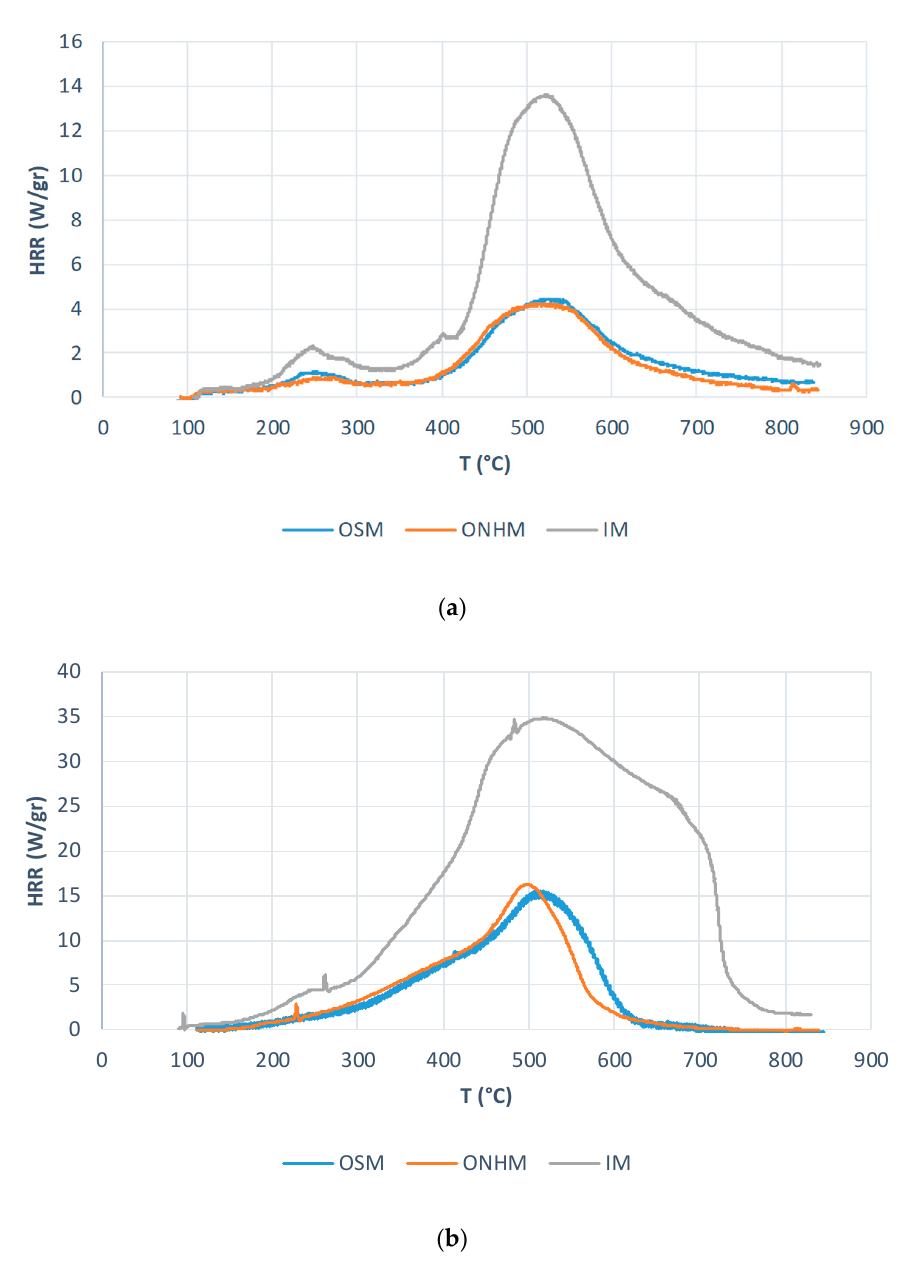
Figure 10. A comparison of HRR curves for the three layers in: An inert stream ( a ) and oxidative stream ( b ) of PCFC.